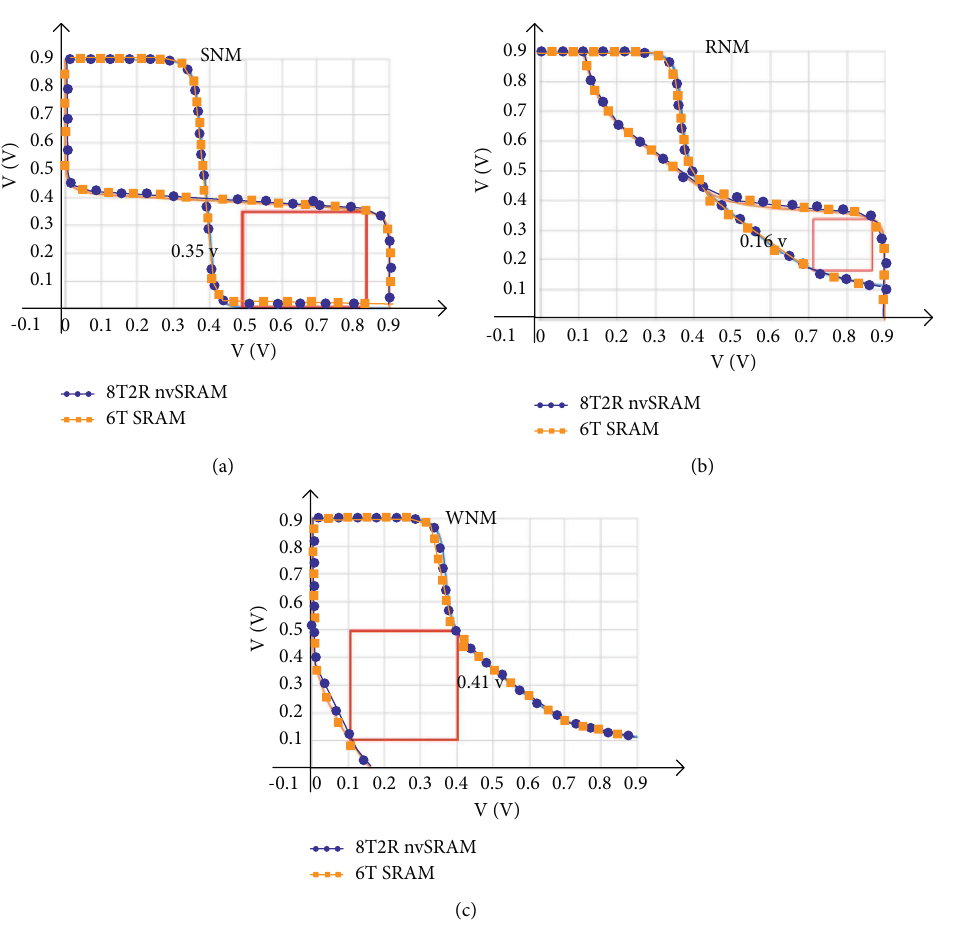
Figure 9: Tree noise margins: (a) static noise margin (SNM); (b) read noise margin (RNM); and (c) write noise margin